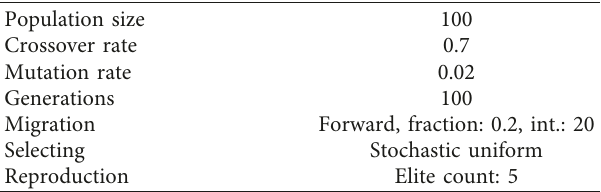
Table 2: The optimization parameters for